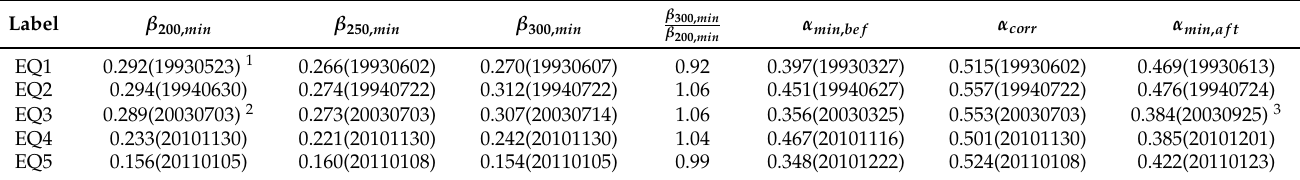
Table 2. The values of β W , min , α min , bef , α corr and α min , aft in the larger area investigated with